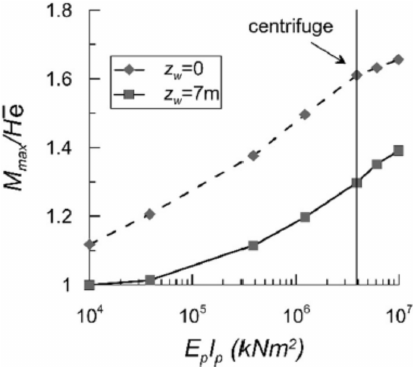
Figure 16. Maximum bending moment in function of the flexural rigidity.